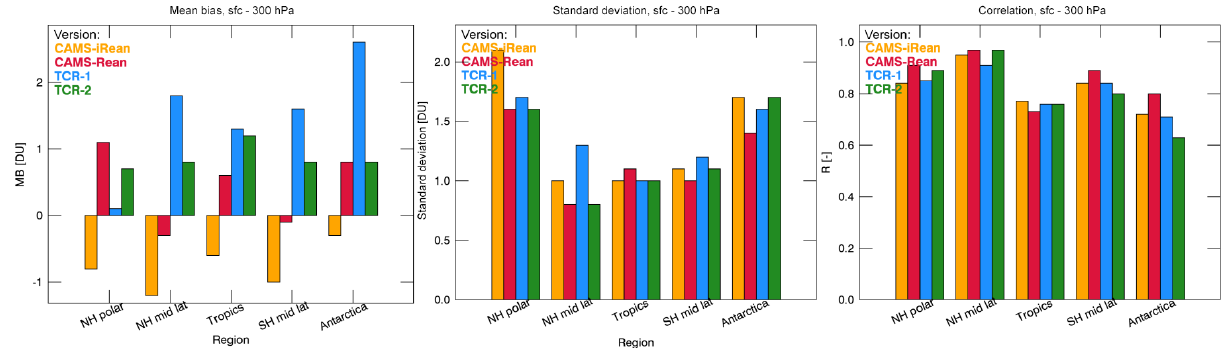
Figure 5. Analogous to Fig. 3 but for partial columns from surface to 300hPa in Dobson units (DU).